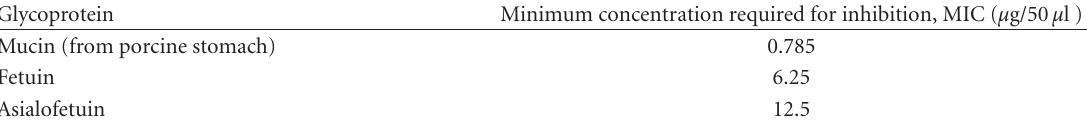
Table 2: Hapten inhibition studies with purified CSL.